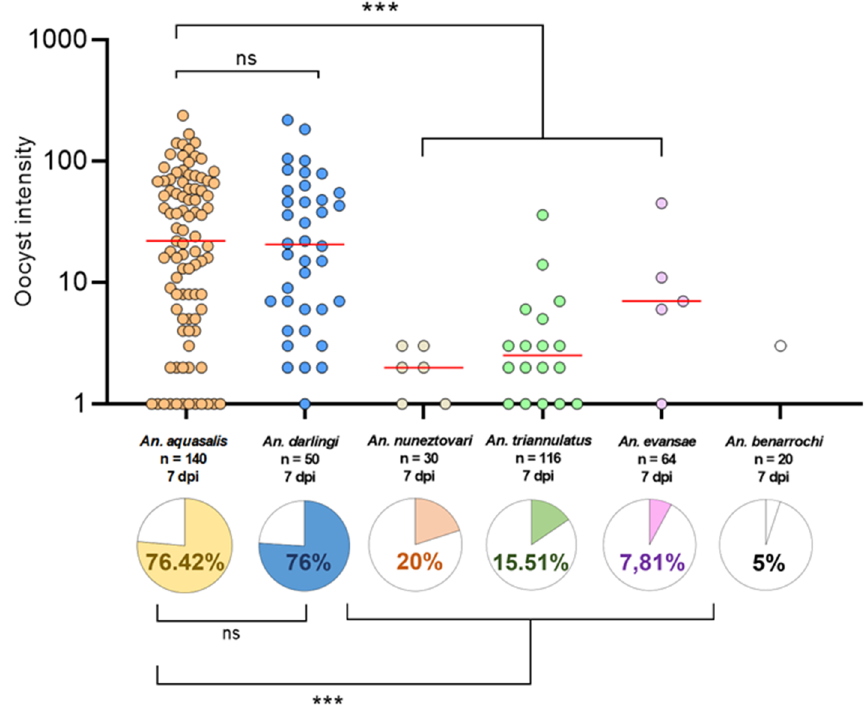
Figure 2. Infection rates and number of P. vivax oocysts in the midgut of six Anopheles species . ***p < 0.0001: Statistically significant; ns: statistically non-significant difference; dpi: days post-infection. Plotted with GraphPad Prism v.6.00 software (San Diego, CA, USA, https:// www. graph pad. com/).